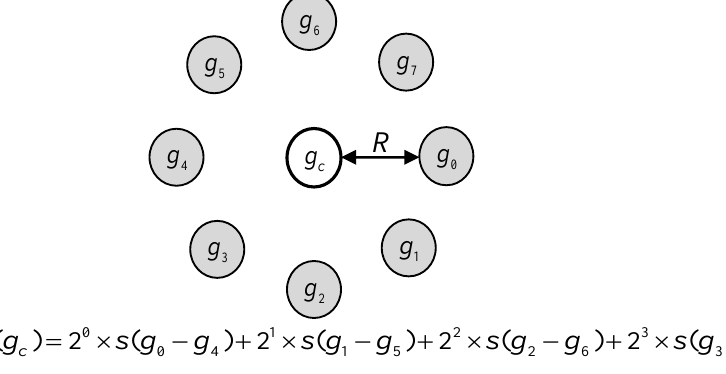
Figure 2. Circularly symmetric neighborhoods and CSLBP feature for radius R and P=8 neighborhood